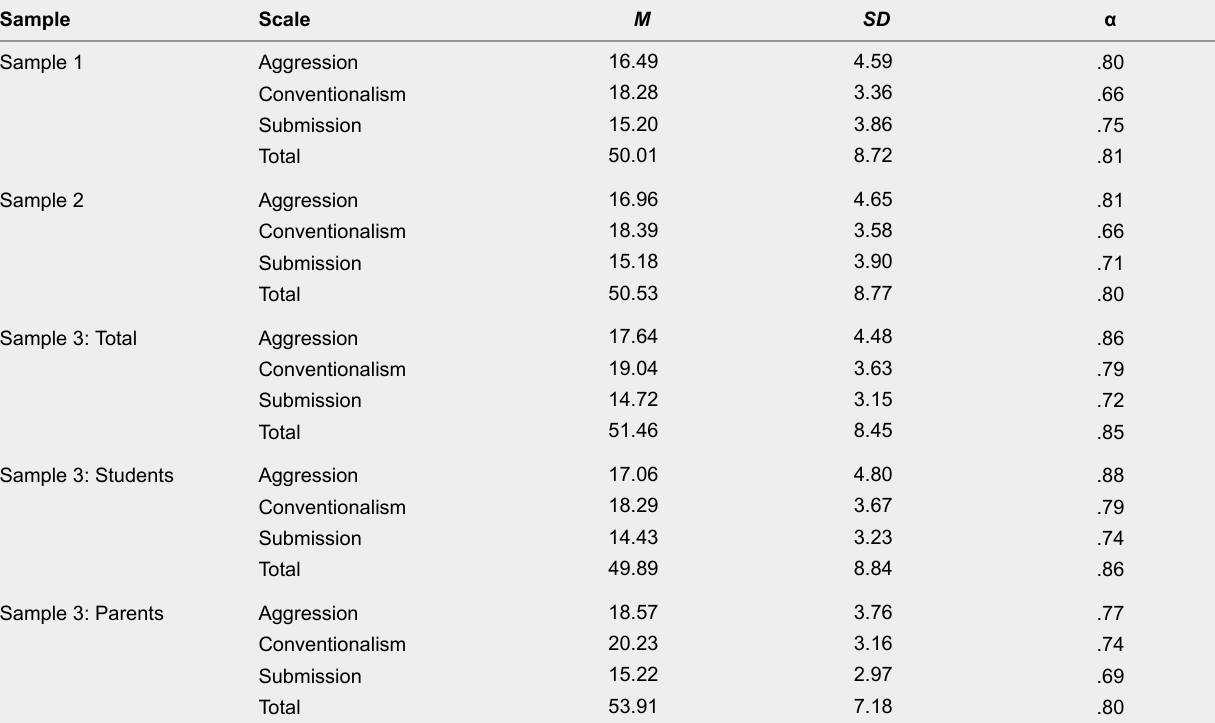
ASC Scale Means, Standard Deviations, and Cronbach’s